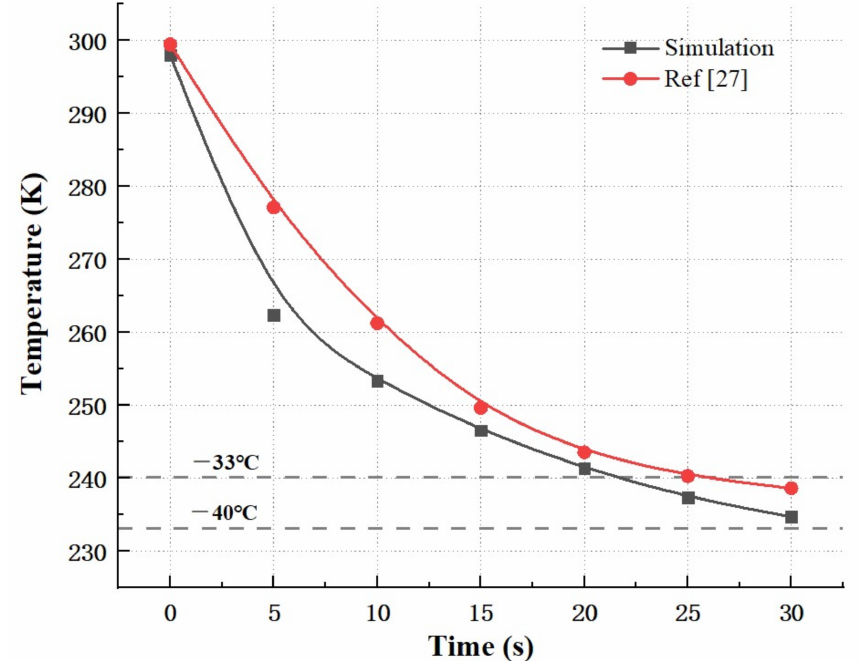
Figure 8. Comparison of simulation data and literature